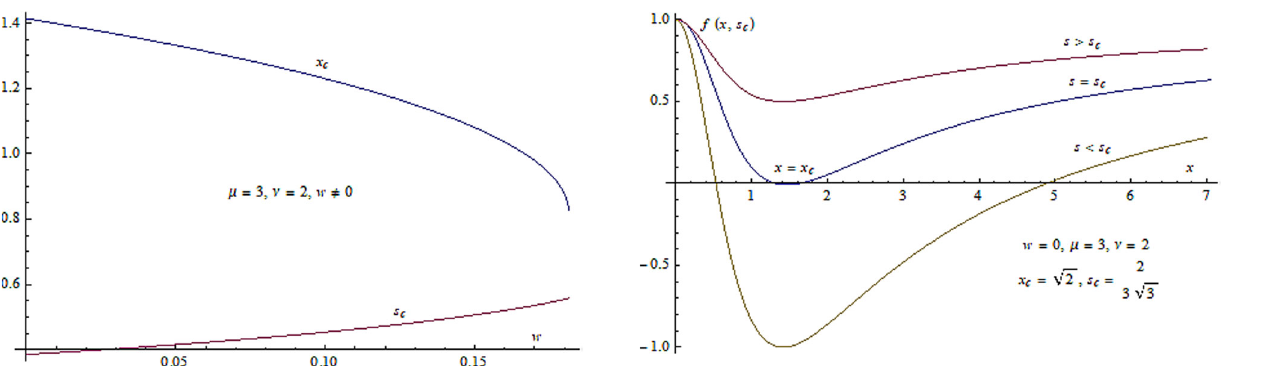
Fig. 1 Plot for x c (w) and s c (w) vs w for μ = 3 ,ν = 2